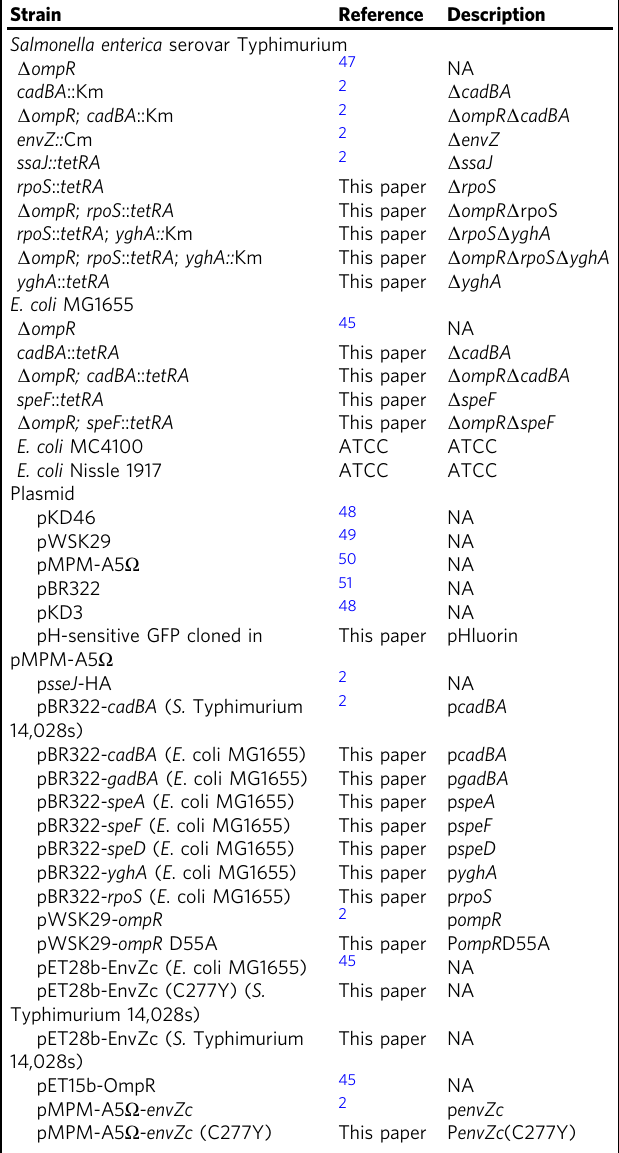
Table 1 Strains and plasmid used in this study